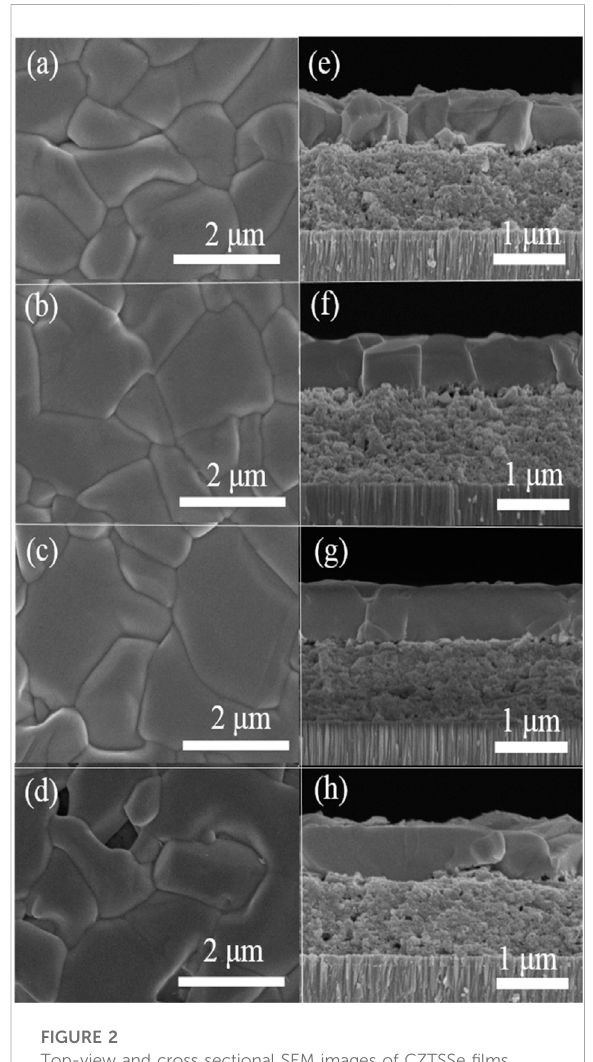
FIGURE 2 Top-view and cross sectional SEM images of CZTSSe fi lms selenized with different Sb 2 Se 3 contents: (A) and (E) 0 mg, (B) and (F) 60 mg, (C) and (G) 70 mg, (D) and (H) 80 mg.